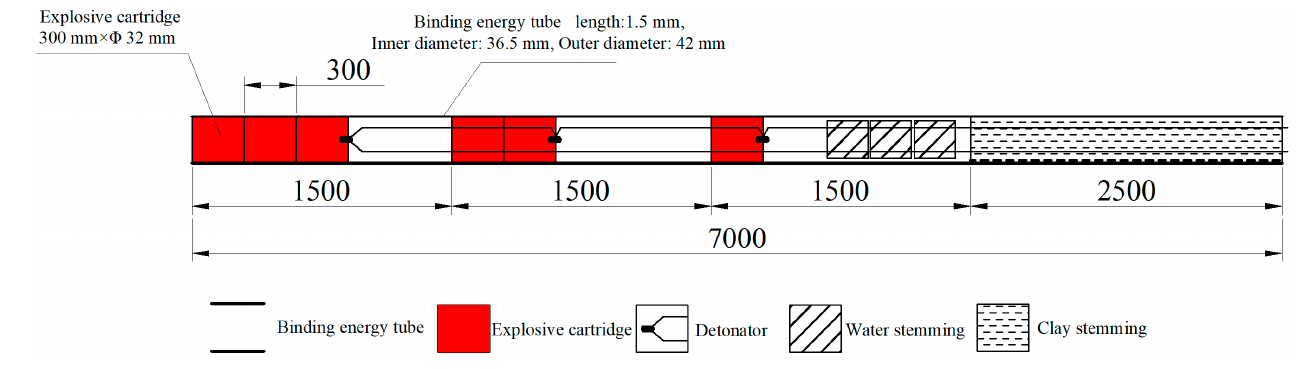
Figure 11. Explosive charge structure.